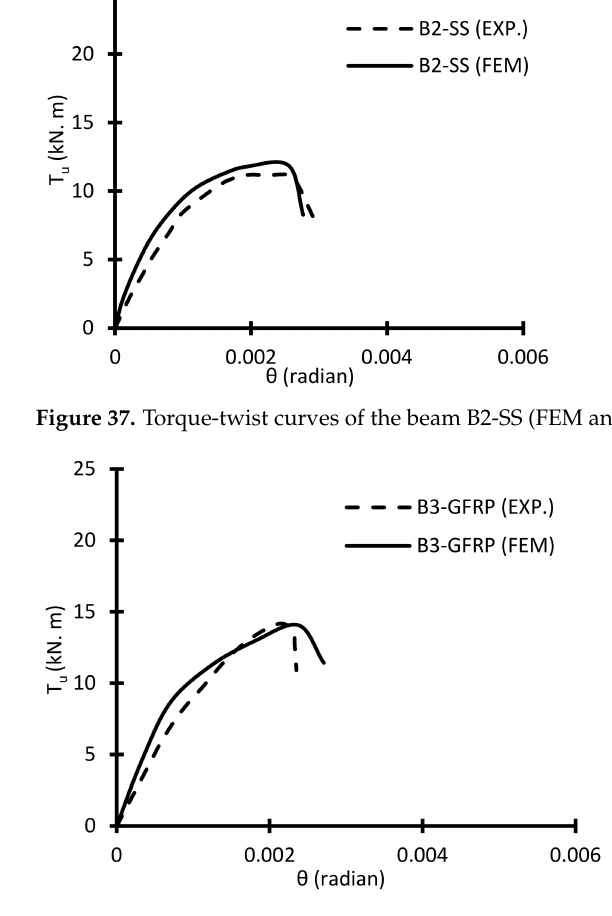
Figure 38. Torque-twist curves of the beam B3-GFRP (FEM and EXP.).